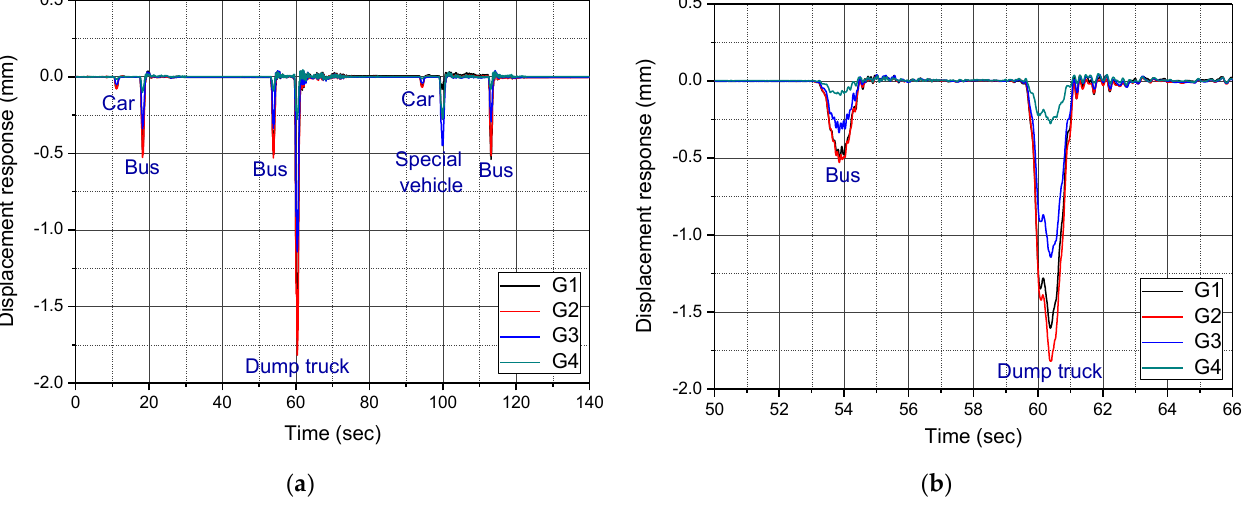
Figure 11. Displacement response measured at each girder in the ambient vibration test: ( a ) displacement response in a specific section; ( b ) displacement response measured between 50 and 66 s. Table 5. Vehicle types and lanes used to estimate LLDF in the ambient vibration test.